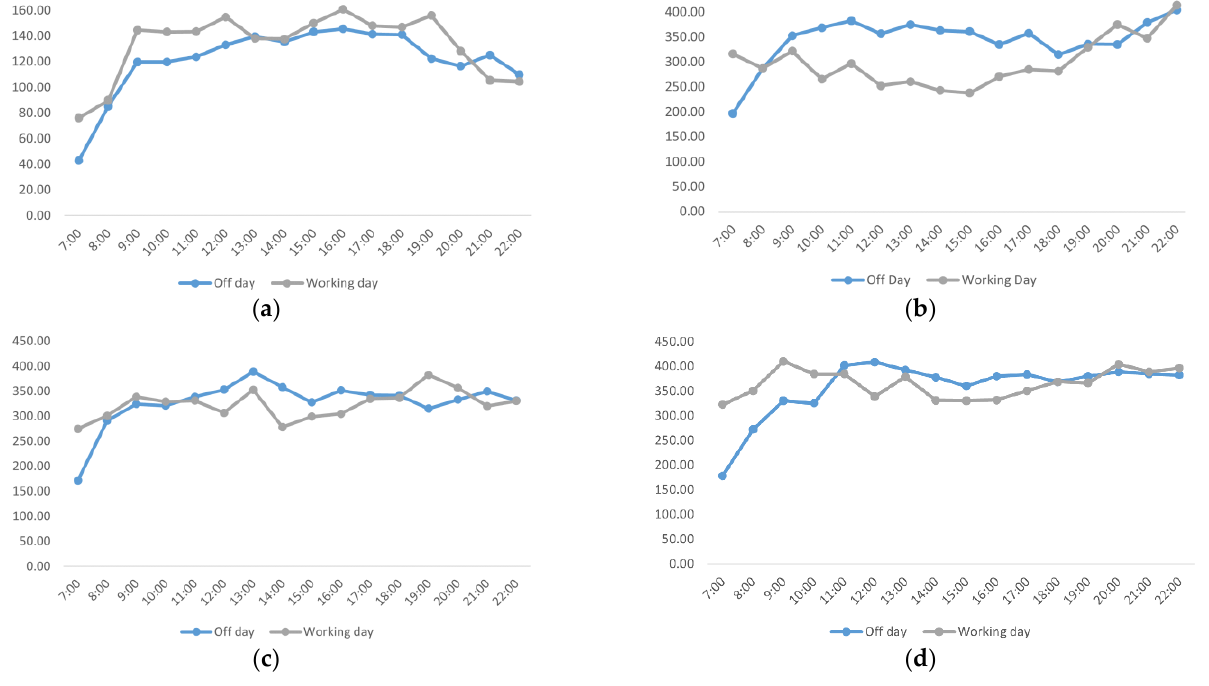
Figure 11. Peak nuclear density of population activity within 500 m of each research station realm: ( a ) XZZX station realm; ( b ) LSY station realm; ( c ) BDJ station realm; ( d ) WYJ station realm.